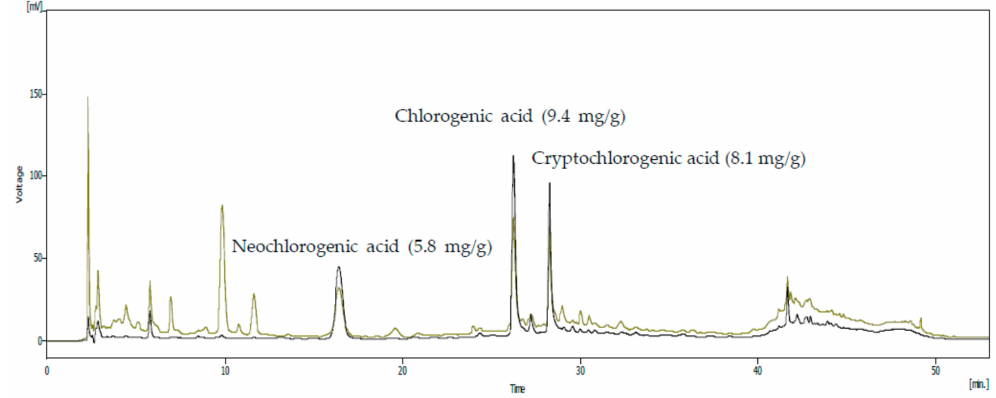
Figure 2. High-performance liquid chromatography of the Stauntonia hexaphylla fruit extract. The mobile phase consisted of solvents A (methanol) and B (0.1% formic acid), run at a flow rate of 1.0 mL/min. Elution conditions were as follows: 0–15 min, 25% A; 15–25 min, 25–40% A; 25–35 min, 40% A; 35–45 min, 40–50% A; 45–55 min, 50–60% A; 55–68 min, 60–100% A; 68–76 min, 100% A; 76–81 min, 100–25% A; and 81–85 min, 25% A. The sample injection volume was 10 µ L. Optimum HPLC separation was achieved at 35 ◦ C and monitored at 254 and 320 nm. AU: arbitrary units.